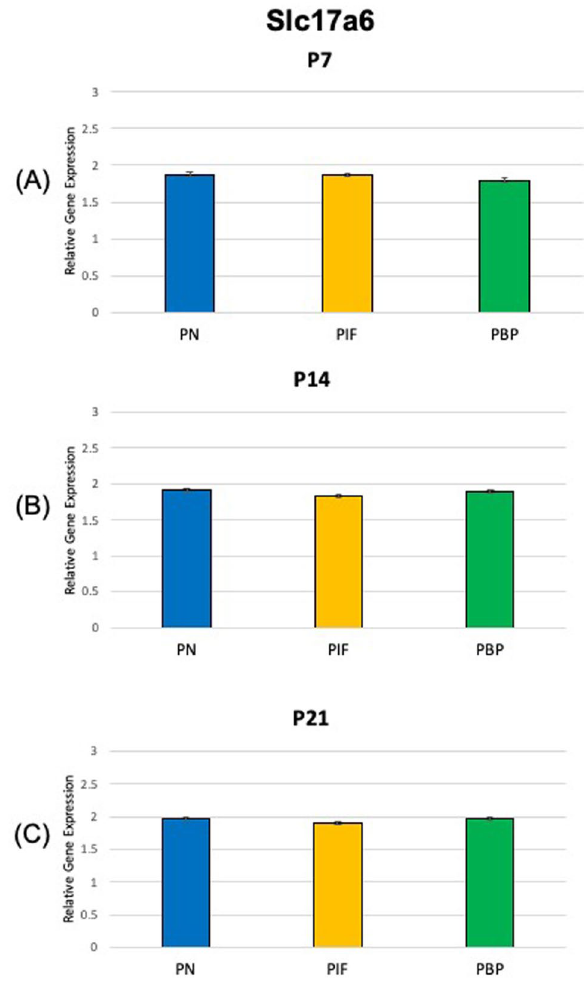
Figure 4. Relative gene expression of Slc17a6 in the VTA sub-regions (PN, PIF, and PBP) of nicotine exposed pups normalized to nicotine treated whole VTA midbrain samples. qPCR was used to identify the expression levels of glutamate neurons for the ( A ) P7, ( B ) P14, and ( C ) P21 day old rat pups. ***p < 0.001, standard deviation. **p < 0.01, ± standard deviation. *p < 0.05 ± standard